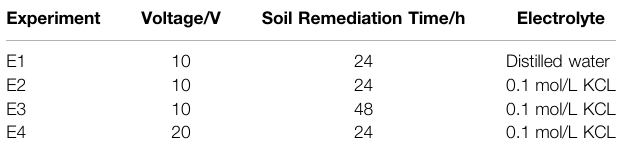
TABLE 4 | Soil experiment